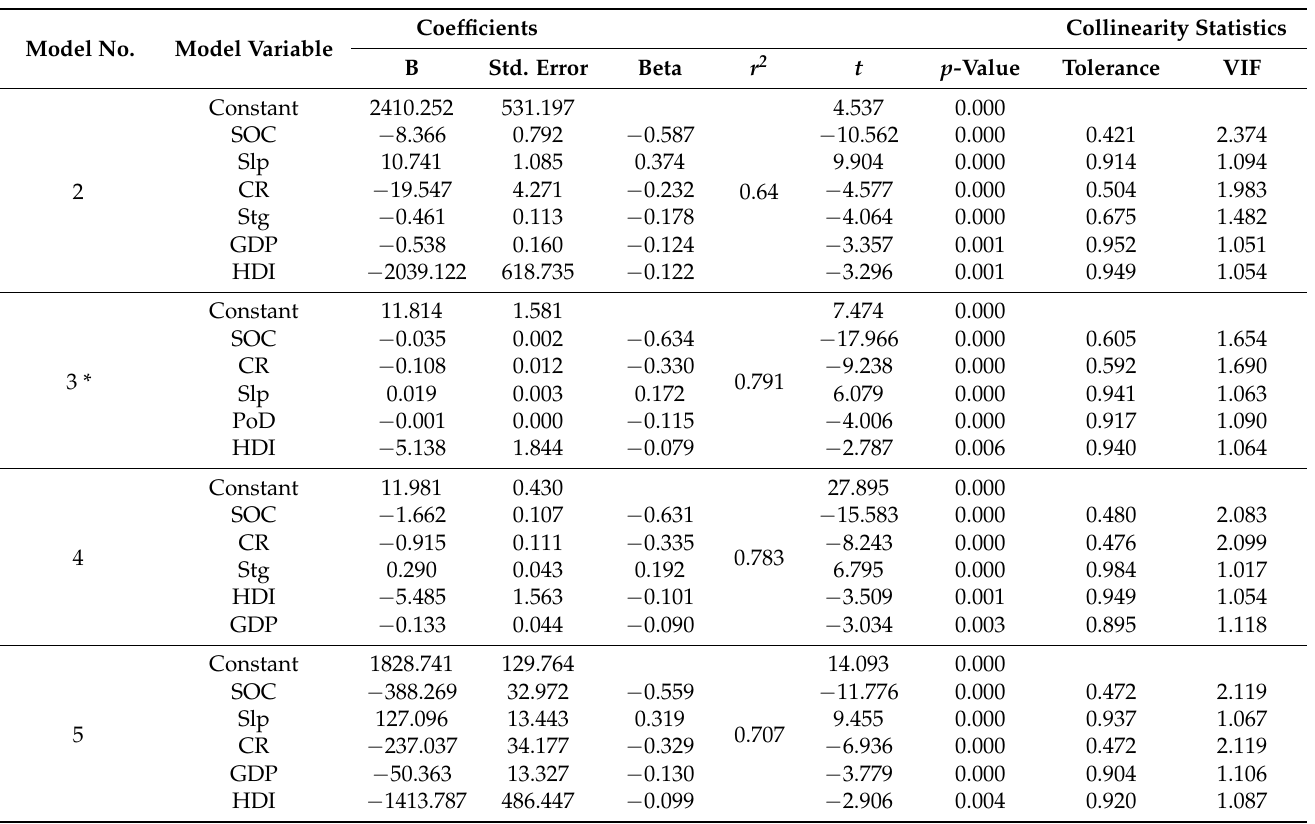
Table 2. Statistics of regression models for soil erosion rate in the study